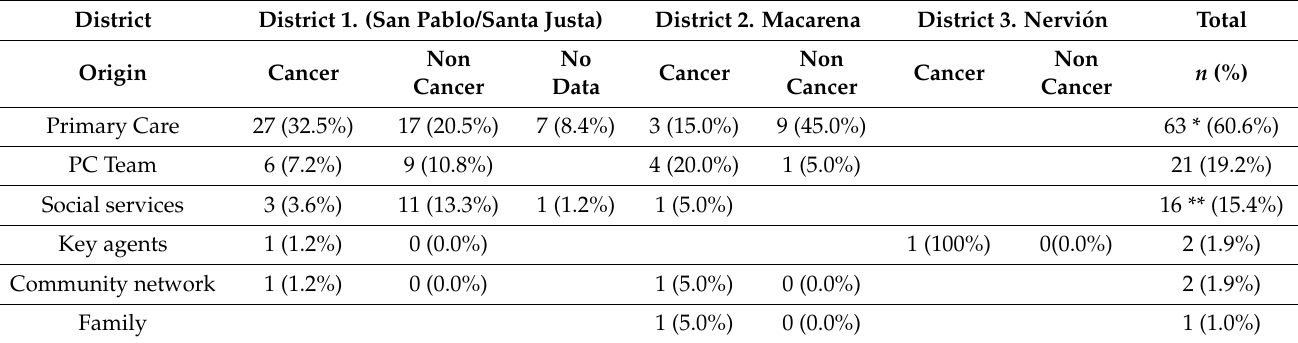
Table 1. Origin of the referral to the